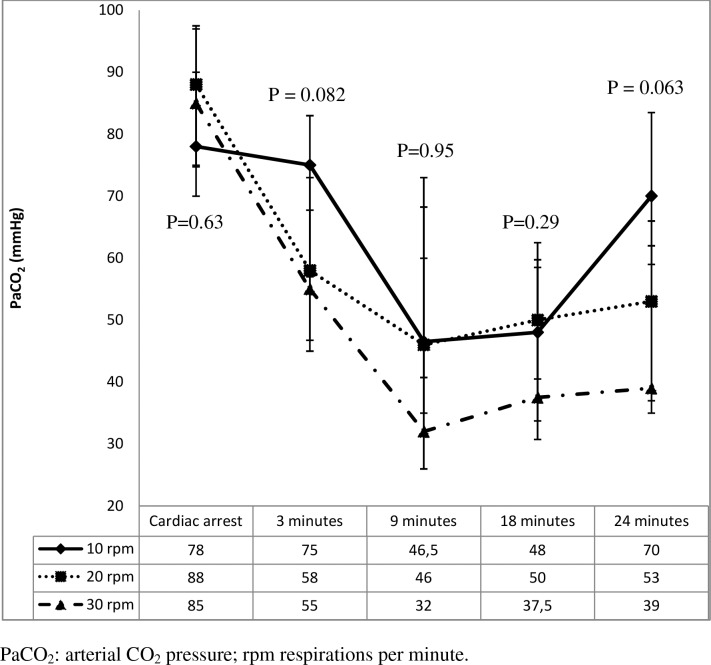
Arterial PCO2 values (mmHg) during resuscitation.